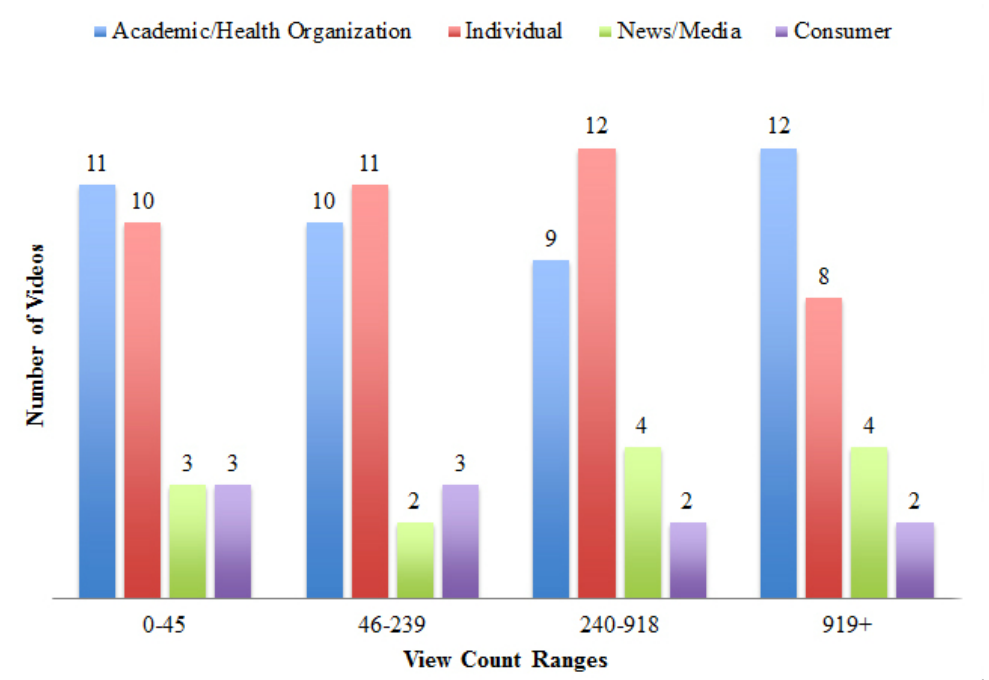
Figure 4. Source of videos presented by interquartile range of